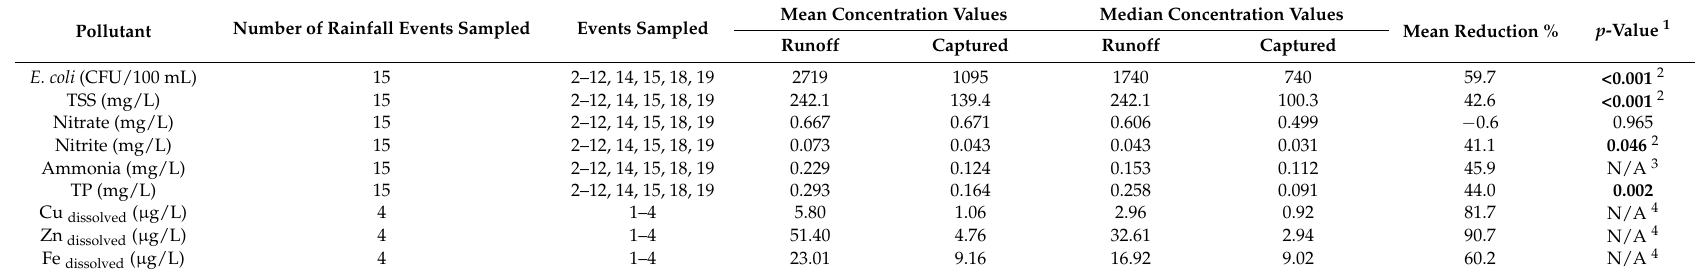
Table 5. Measured pollutant concentrations and observed mean reductions, GI 17G (trench system).